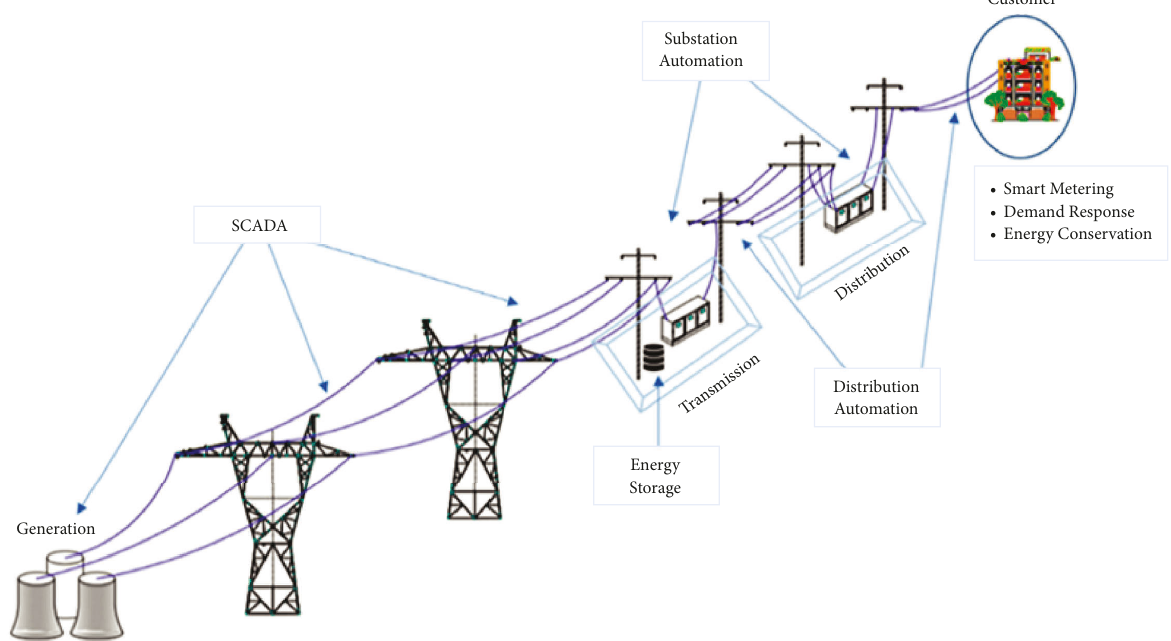
Figure 3: The idea of a communication and control system in smart grid